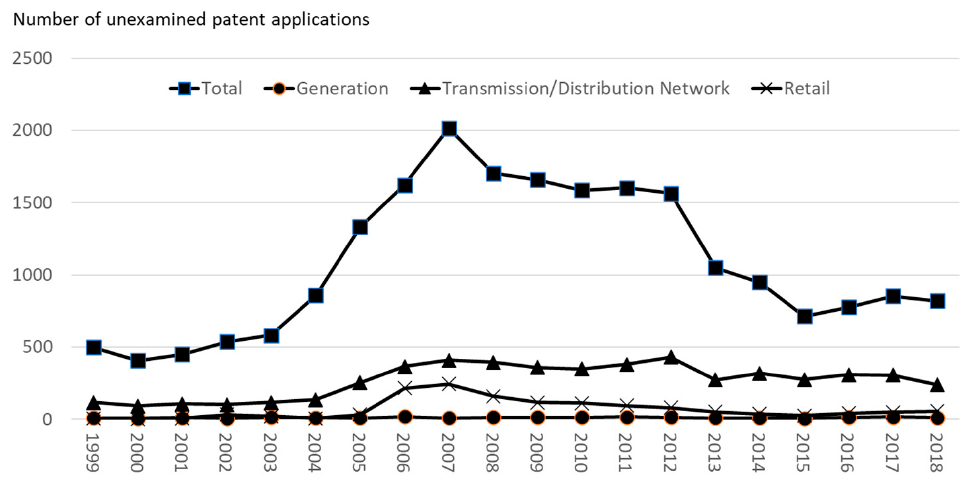
Figure 1. Trend of patent applications for total, generation, transmission/distribution network and retail. Note: The number for total is not equal to a simple sum of numbers of each function, because total of a company includes a wide range of sub-classes that are not listed in Table 1. Supplementary data was obtained from the financial statements of each company.